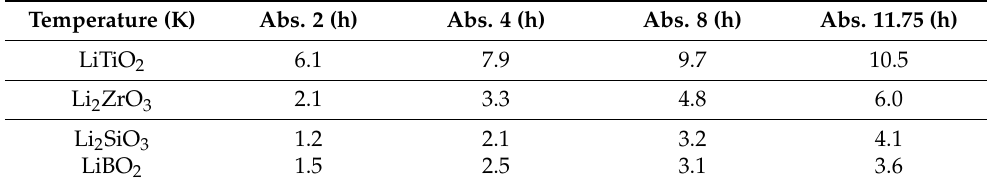
Figure 10. Comparison of weight percentage of sol–gel synthesized lithium-based oxides at 333 K. Table 9. Mass increasing rate of lithium-based oxides for the absorption time of 2–11.75 h.